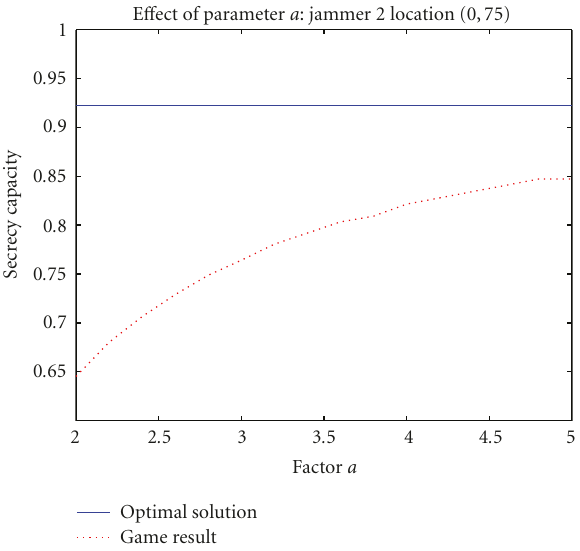
Figure 10: E ff ect of the parameter a on the game.